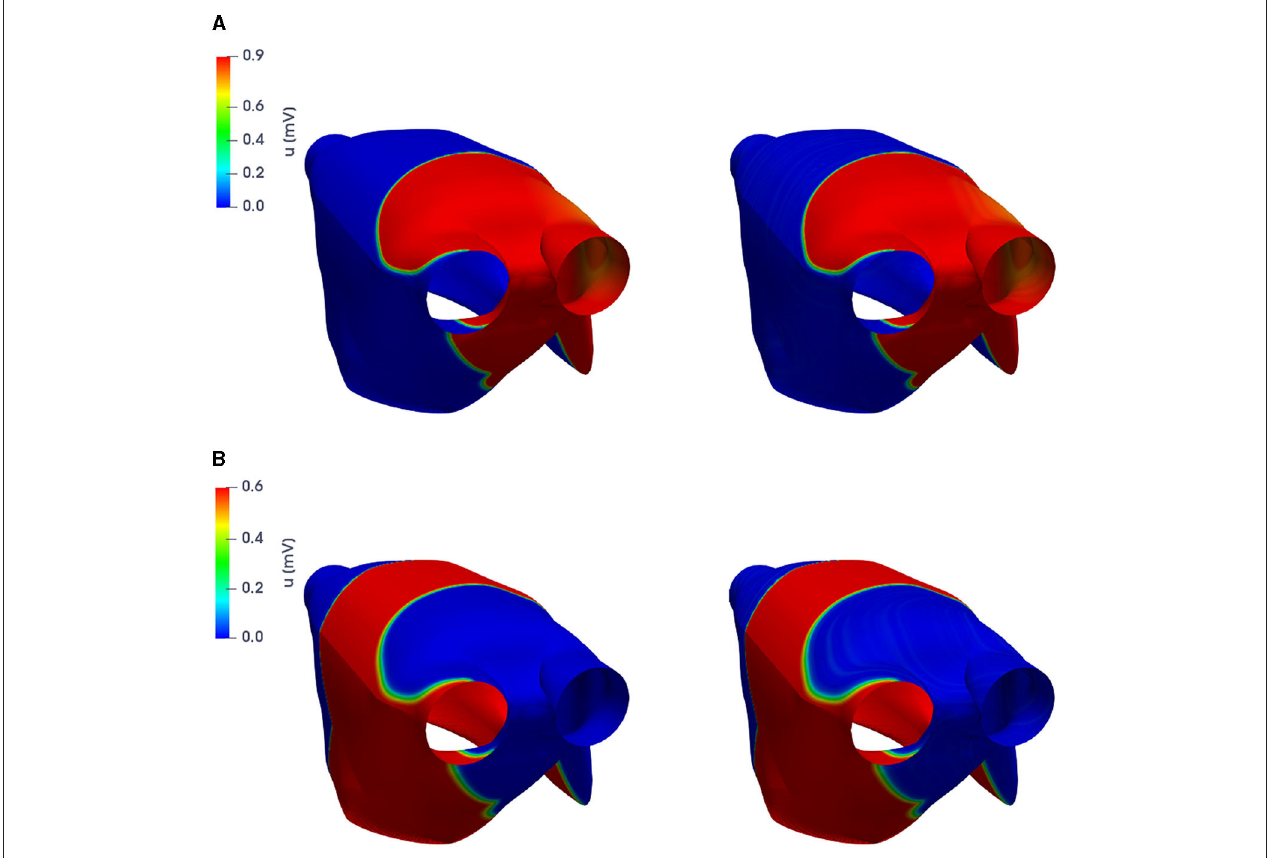
FIGURE 4 | Test 1.2 : FOM solution (left) and POD-DL-ROM one (right), with n = 2 and N = 256, for the testing-parameter instance µ test = 0.0295 (cid:127) − 1 cm − 1 at t = 52.8 ms (A) and t = 112 ms (B)